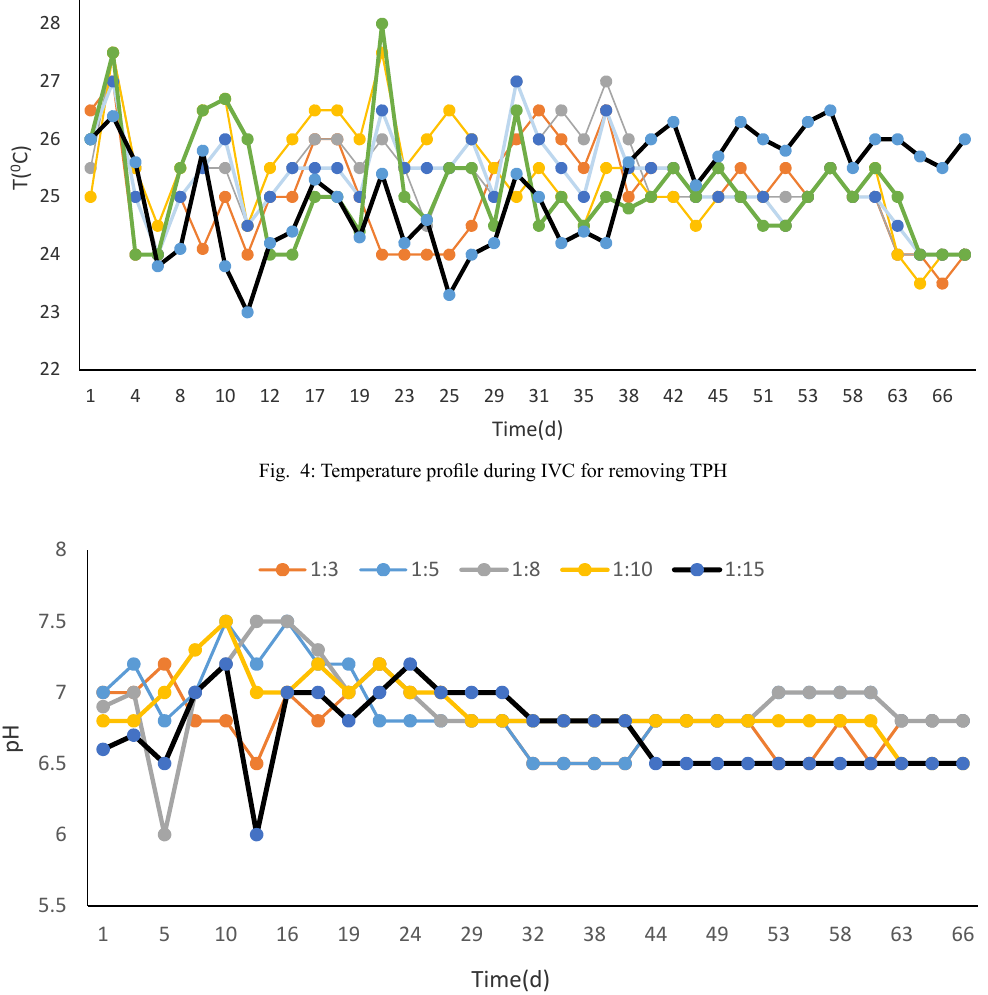
Fig. 5: pH profile during IVC for removing TPH